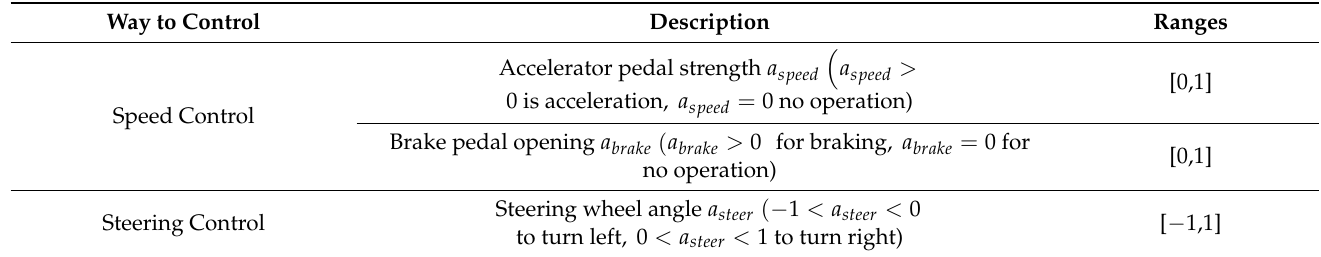
Table 2. List of action space sets.